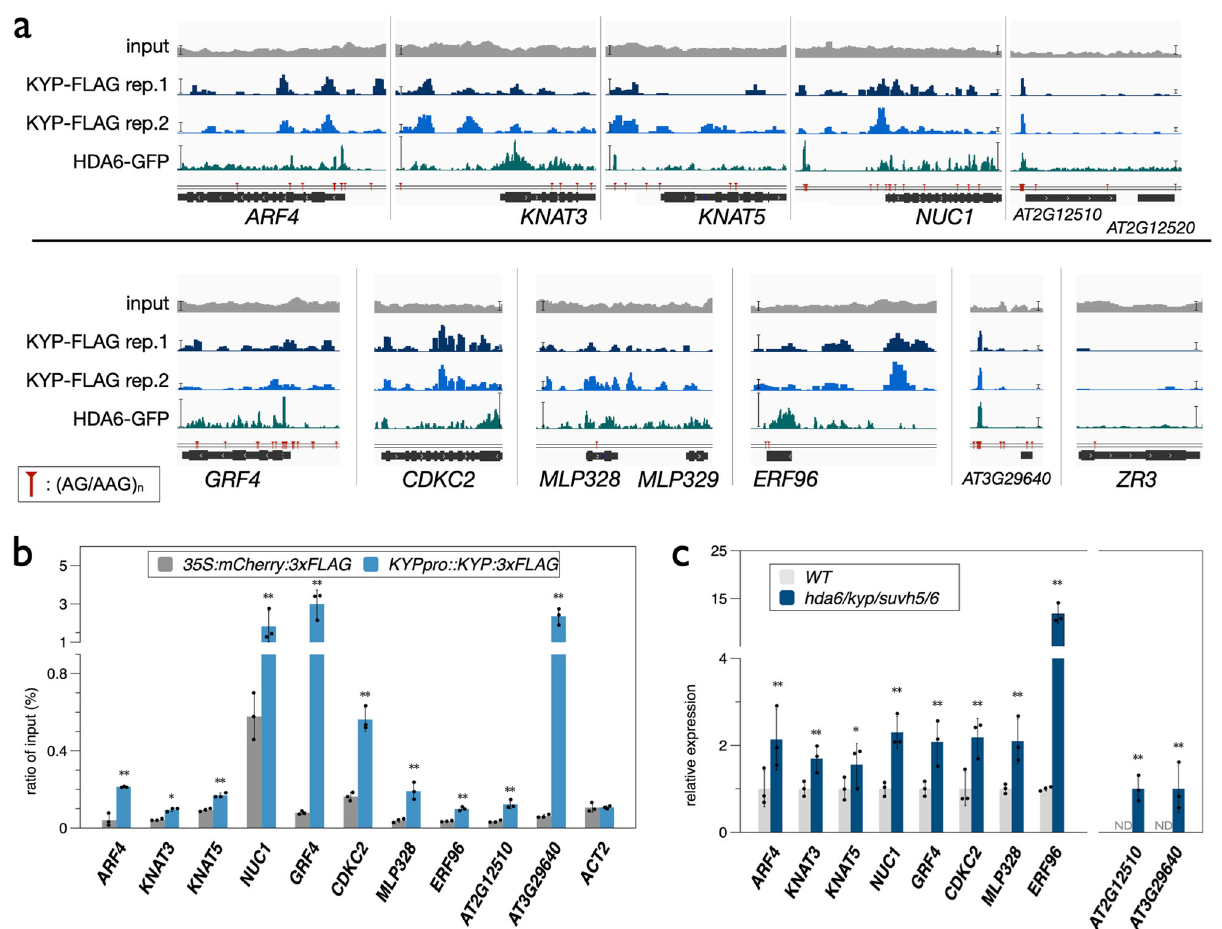
Fig. 7 The binding and expression of KYP regulated genes. a Integrated Genome Viewer showing the binding of KYP and HDA6 in selected genes. Bars: normalized reads = 10. Red pinpoints: (AG/AAG) n repeat motifs. b , c KYP binding ( b ) and expression ( c ) of selected genes. ChIP assays were performed with the anti-FLAG antibody. The amount of immunoprecipitated DNA was quanti fi ed by qPCR. Values represent the normalized average immunoprecipitation ef fi ciencies (%) against the total input DNA. UBQ10 was used as an internal control. ND: not detected. Error bars correspond to SD. * p < 0.05, ** p < 0.005 (Student ’ s t test). At least three independent biological replicates were performed with similar